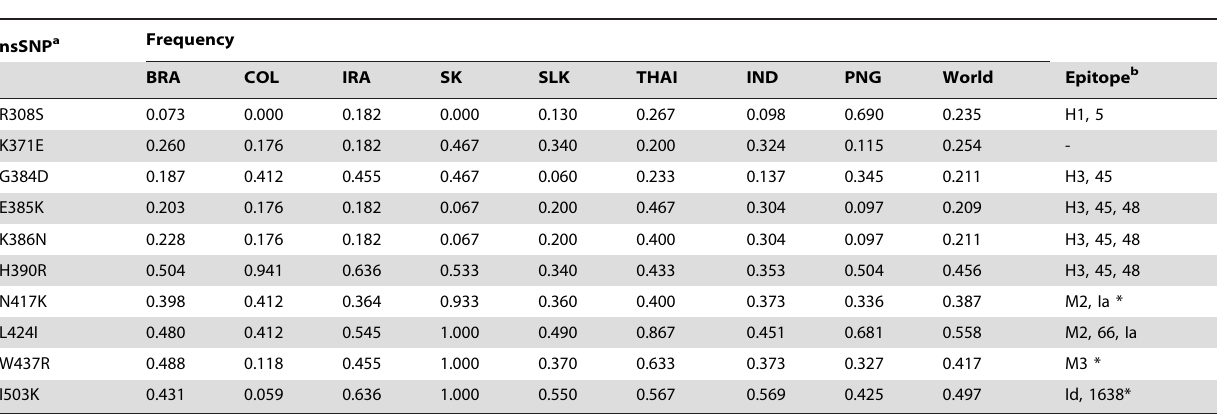
Table 2. Description of the most frequent nonsynonymous (nsSNPs) polymorphisms used to construct DBP II haplotypes, their frequencies in each geographic population and presence in described